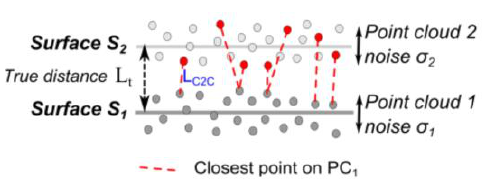
Figure 6. Simplest cloud-to-cloud distance based on the closest point distance (Lague, et al.,